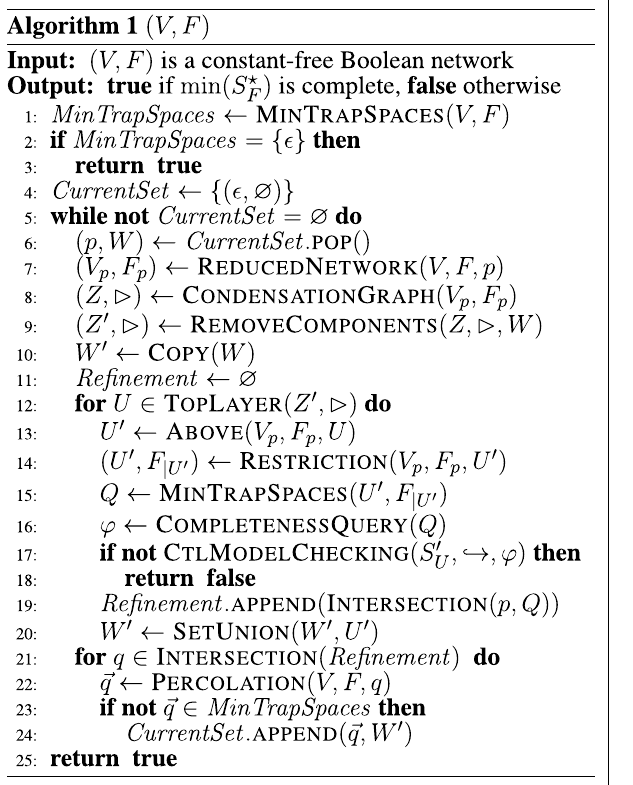
FIGURE 3 | The iterative, refinement-based algorithm for deciding the question of completeness . See main text for a detailed